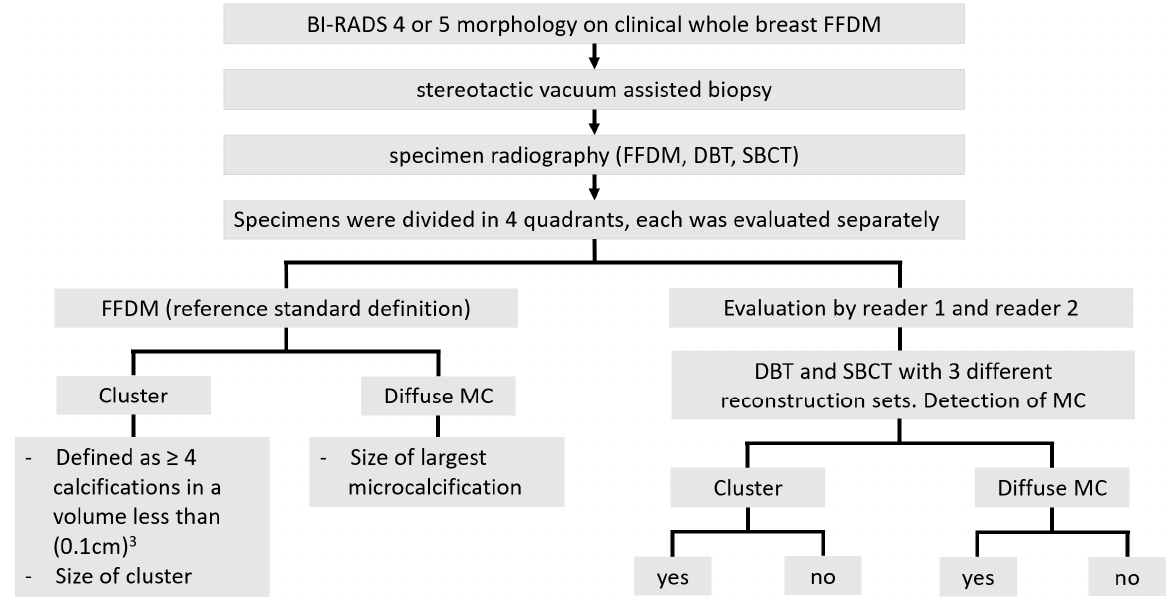
Figure 3. Study workflow. A study coordinator defined microcalcifications in FFDM and classified them as either clusters or diffuse distributed (left side). The two blinded readers evaluated DBT and SBCT reconstructions (right side). Microcalcifications (MCs), full-field digital mammography (FFDM), digital breast tomosynthesis (DBT), and spiral breast computed tomography (SBCT).